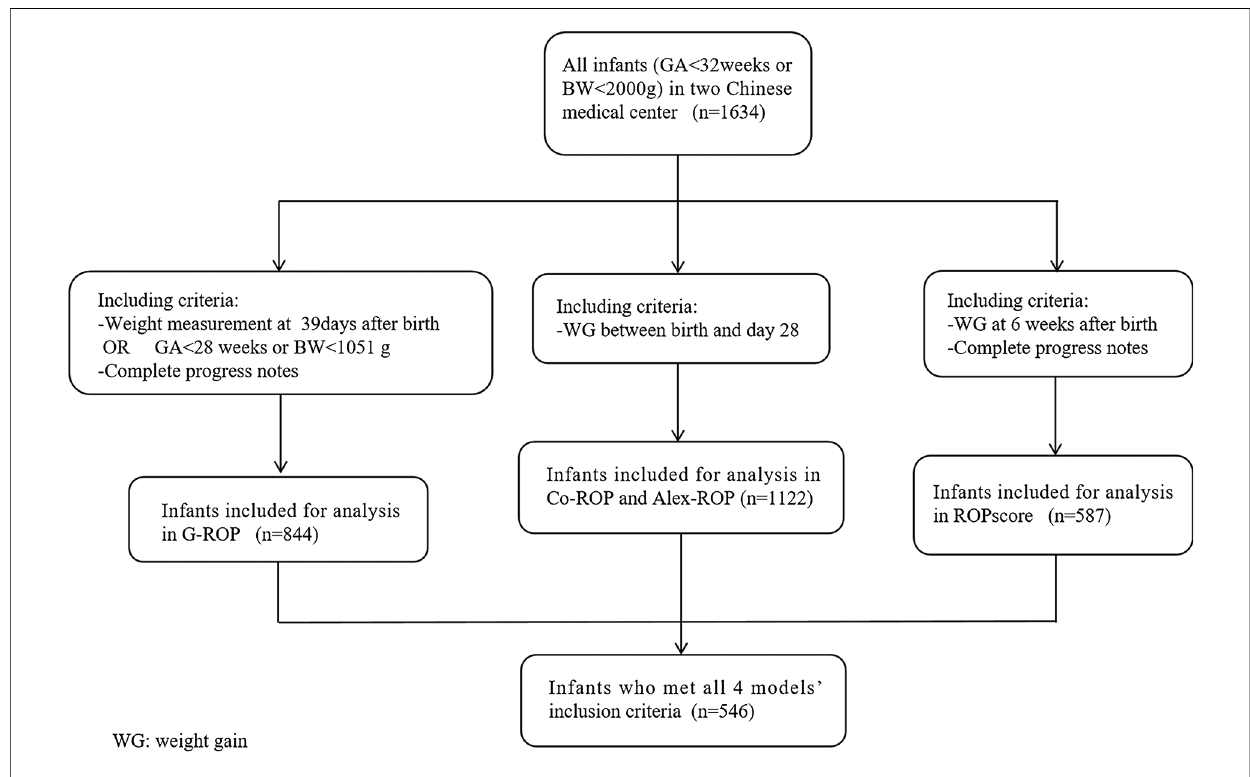
FIGURE 1 Flow diagram showing the including criteria for the infants in different